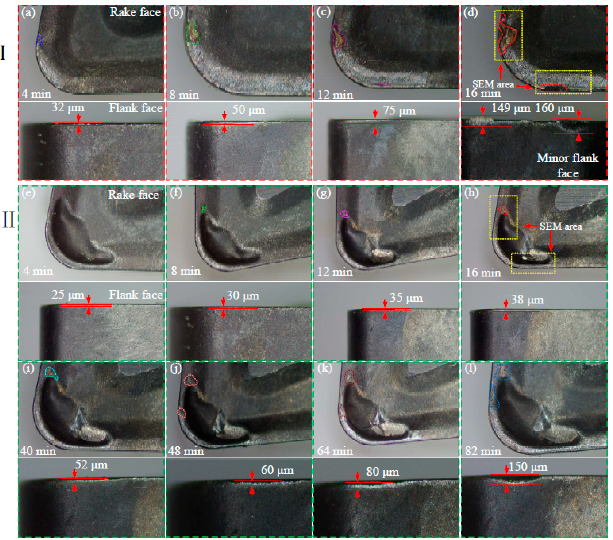
Figure 5. ( І ) Wear morphology of rake and flank face of Tool A. ( II ) Wear morphology of rake and flank face of Tool B.